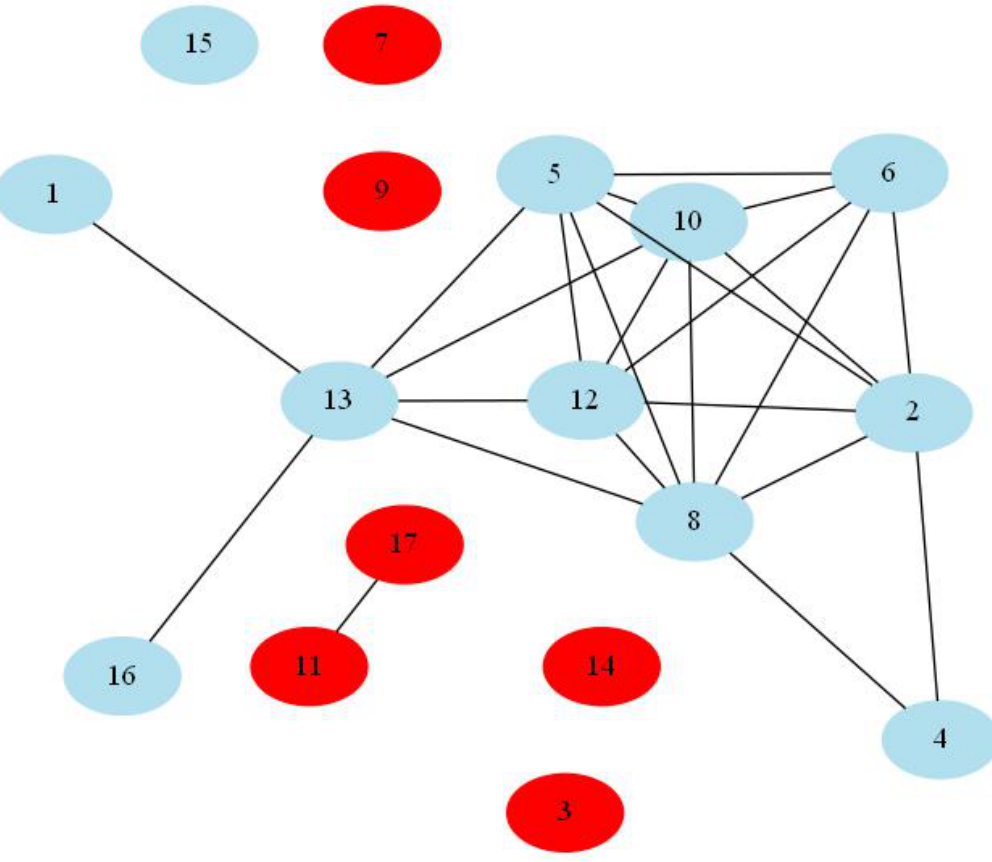
Figure 9: As Fig. 8, but with NCD computed using the bzip2 compressor. Notice the meaningful link between Chapters 11 and